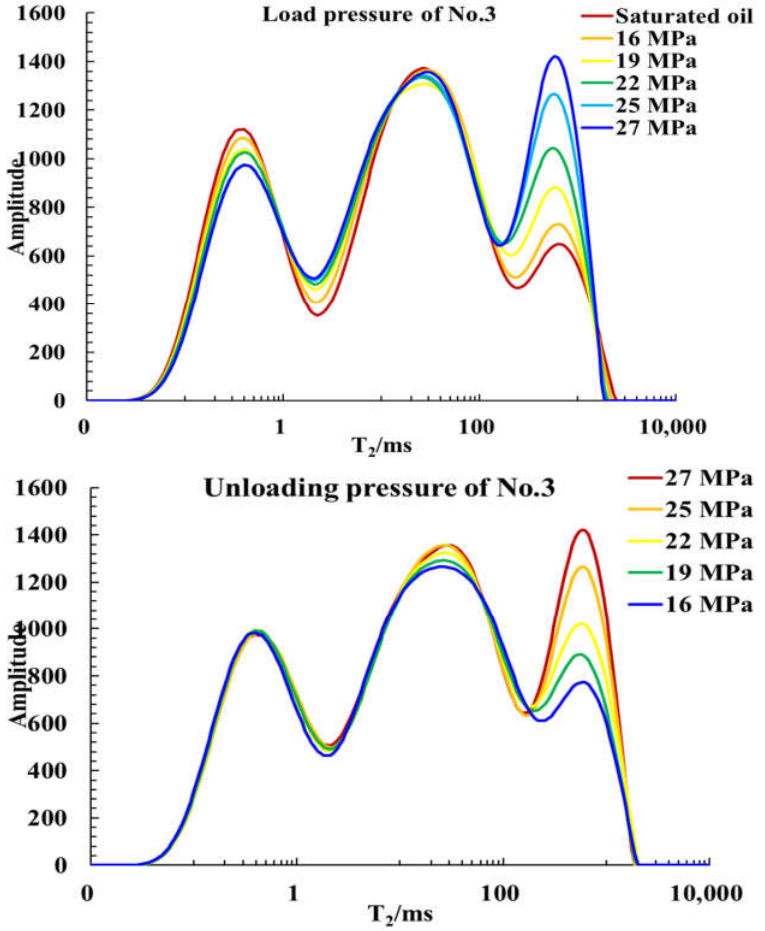
Figure 3. NMR T 2 spectrum of matrix rock samples under different pore pressures.